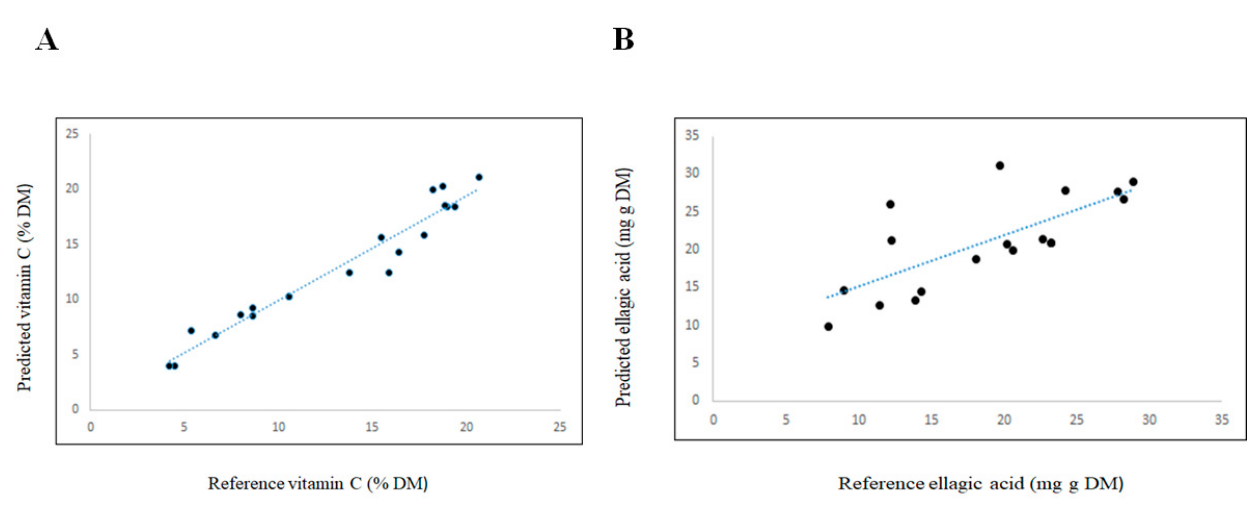
Figure 2. Partial least square loadings for the measurement of vitamin C and ellagic acid in pureed Kakadu plum fruit samples.